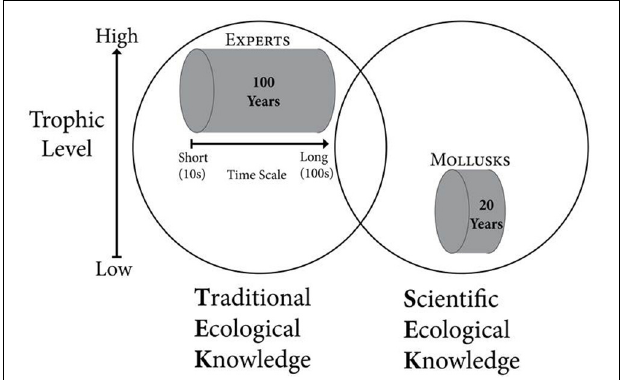
FIGURE 1 | Conceptual model for integrating traditional ecological knowledge (TEK) and scientific ecological knowledge (SEK) of ecosystem change. Experts and Mollusks represent members of the human population and ecosystem (represented by the circles), respectively, who accurately monitor environmental conditions. Experts generally rely on information gathered at mid-high trophic levels (and are themselves usually at these trophic positions) while mollusks reflect conditions at low-mid trophic levels. The length of the cylinders represents the time scale covered by each source of environmental